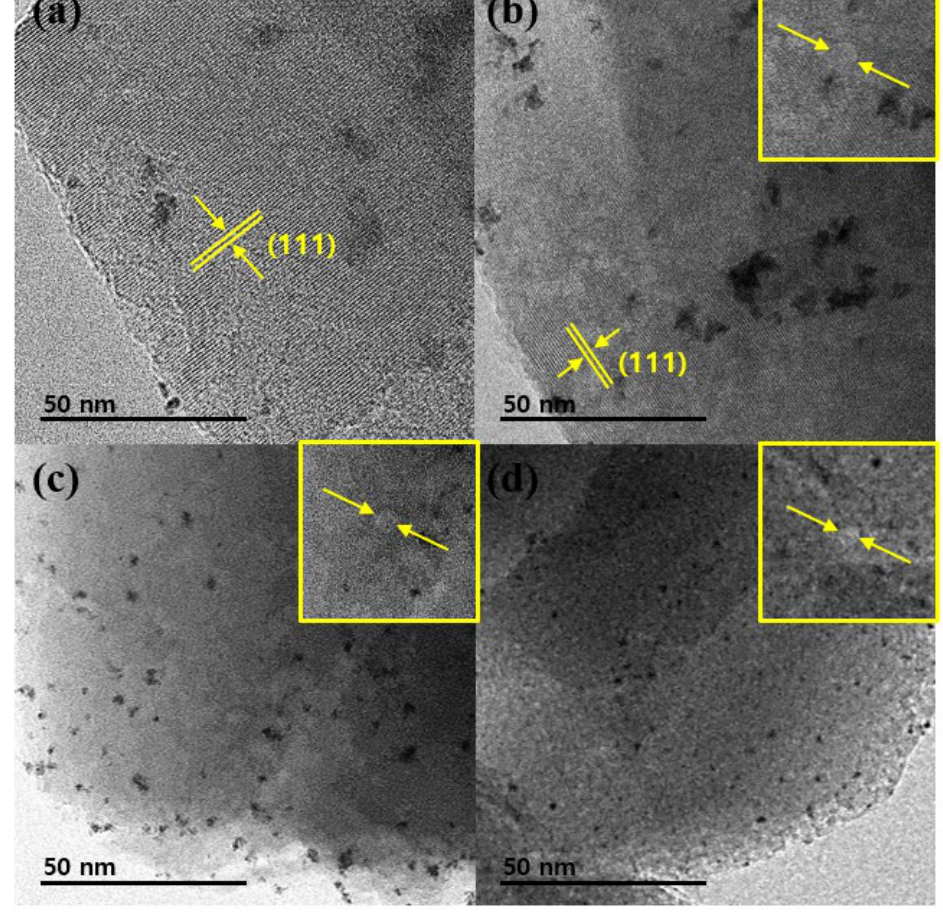
Figure 3. Transmission electron microscopy (TEM) images of the Pt/Y zeolites ( a ) Pt/Y, ( b ) Pt/Y-2h, ( c ) Pt/Y-4h, and ( d ) Pt/Y-6h. The arrows indicate mesopores. Table 2. Transmission electron microscopy (TEM), X-ray photoelectron spectroscopy (XPS), induc- tively coupled plasma-atomic emission spectrometry (ICP-AES), and CO chemisorption analysis results for the Pt/Y zeolites.